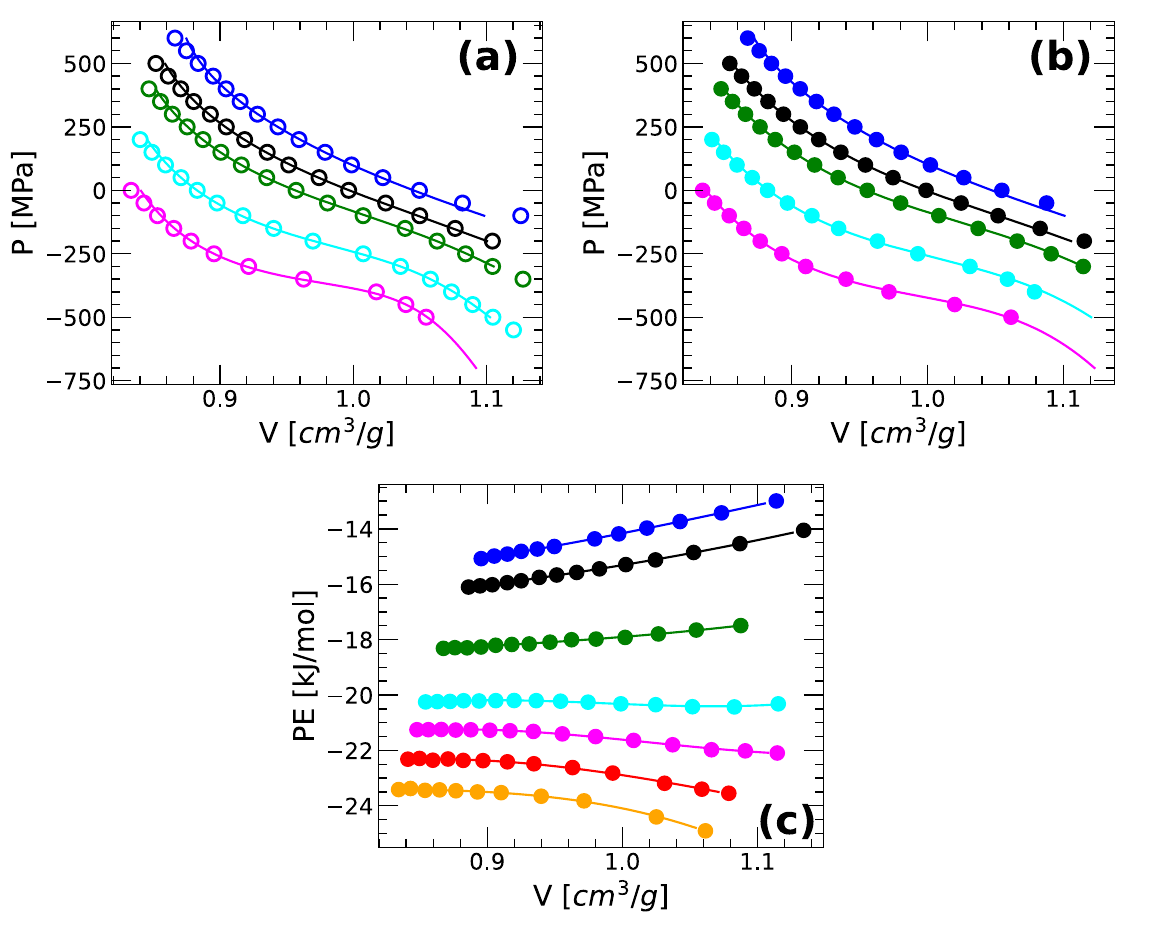
Figure 2. Pressure of q-TIP4P/F water as a function of volume along selected isotherms. Circles are results from ( a ) classical MD and ( b ) PIMD simulation. The solid lines are the results from the TSEOS. Isotherms correspond to (top to bottom) T = 300, 260, 240, 220, 200 K and are shifted by δ P = 100, 0, − 100, − 300, − 500 MPa, respectively. An inflection point in P ( V ) seems to develop at T < 200 K consistent with the existence of a LLPT in q-TIP4P/F water at lower temperatures. ( c ) Potential energy for selected isotherms at (bottom to top) T = 200, 220, 240, 260, 300, 350, 375 K. Solid symbols are from PIMD simulations; lines are guides to the